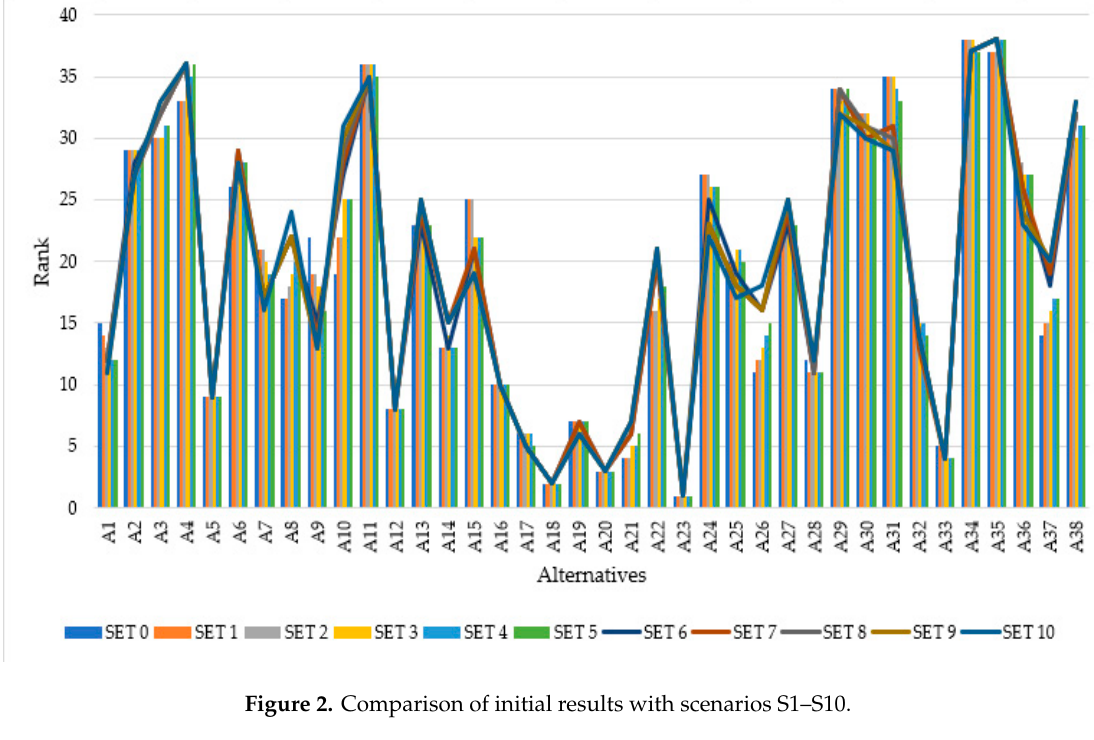
Figure 2. Comparison of initial results with scenarios S1–S10. Mathematics 2020 , 8 , 457 13 of 17